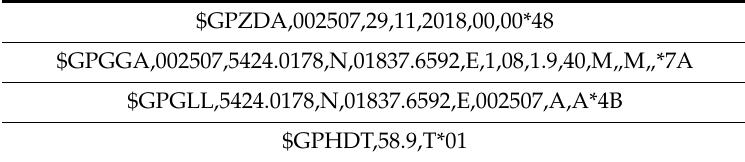
Table 1. Satellite compass observations in the NMEA format from a selected measurement epoch.